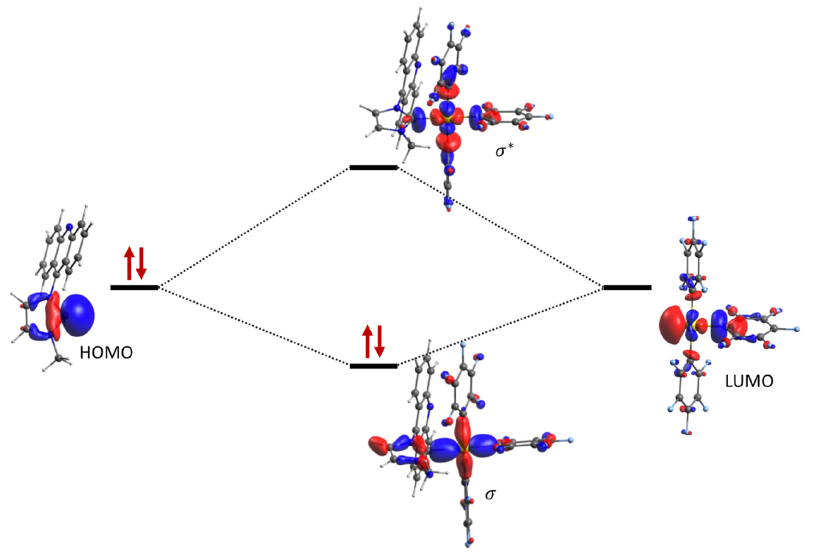
Figure 9. Diagram of the σ interaction between 1-(9-acridine)-3-methylimidazol-2-ylidene and [Au(C 6 F 5 ) 3 ] species enabling the formation of complex 3 . The σ ∗ orbital of complex 3 had a ~70% greater weight than the Au 5d x 2 − y 2